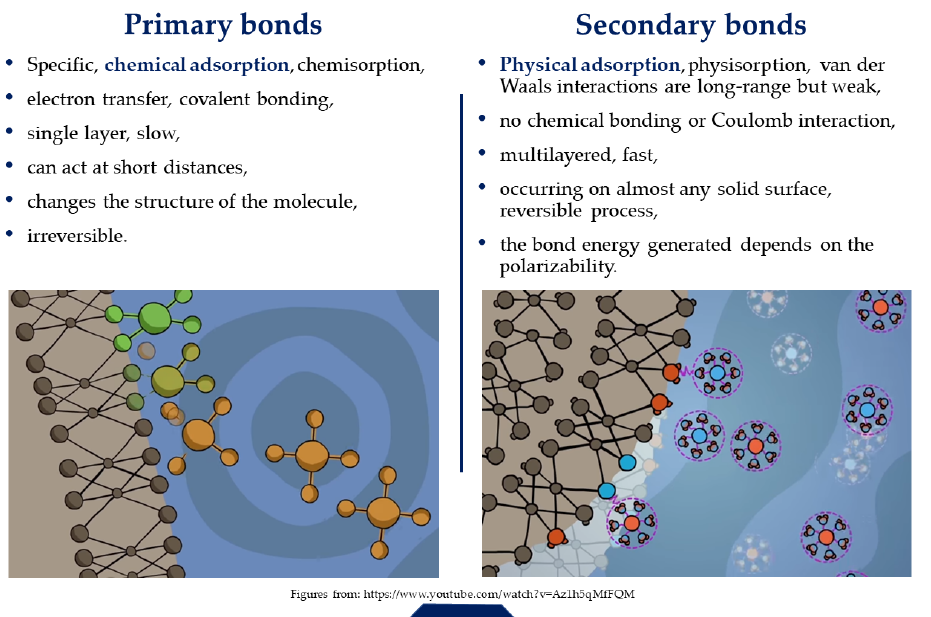
Figure 4. Types of adsorption bonds and nature of adsorption.